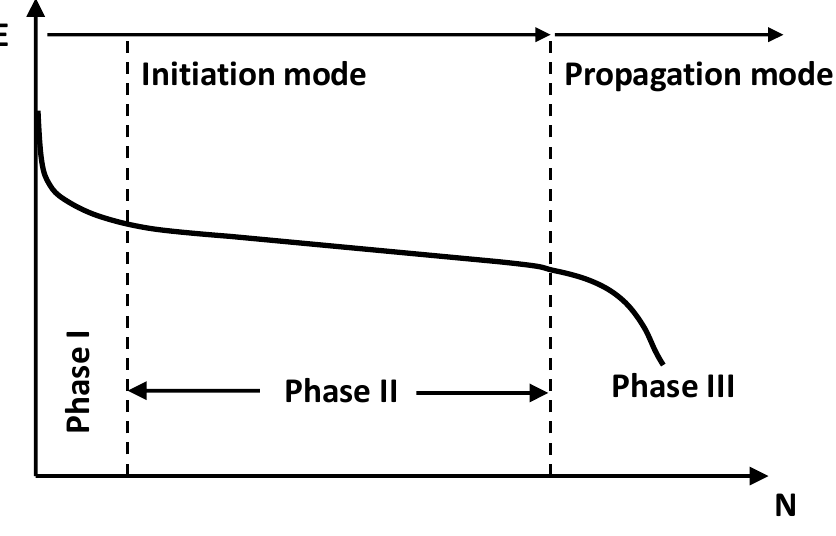
Figure 1. Fatigue graph with the phases.